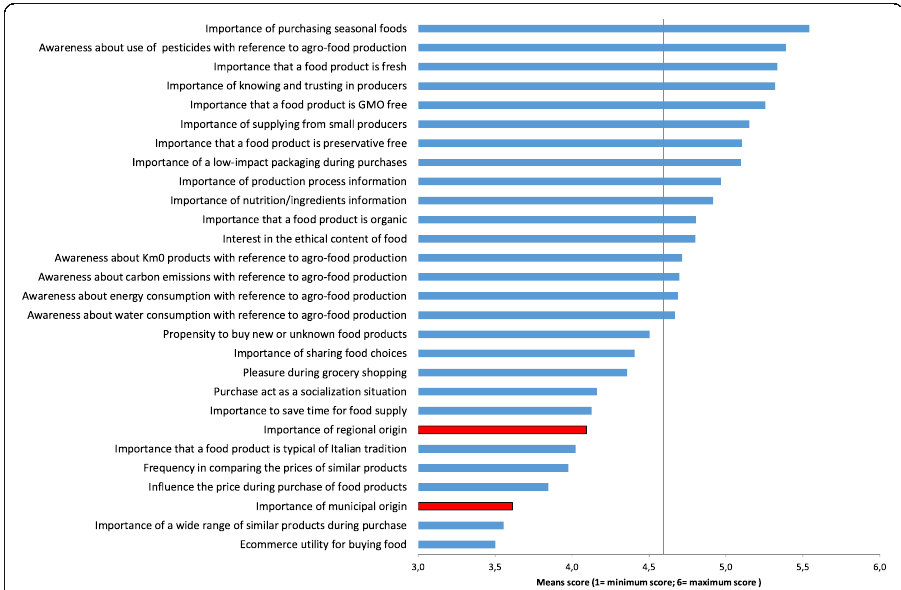
Fig. 2 Importance assigned by respondents to the different questions (mean scores). Source: our elaborations from sample